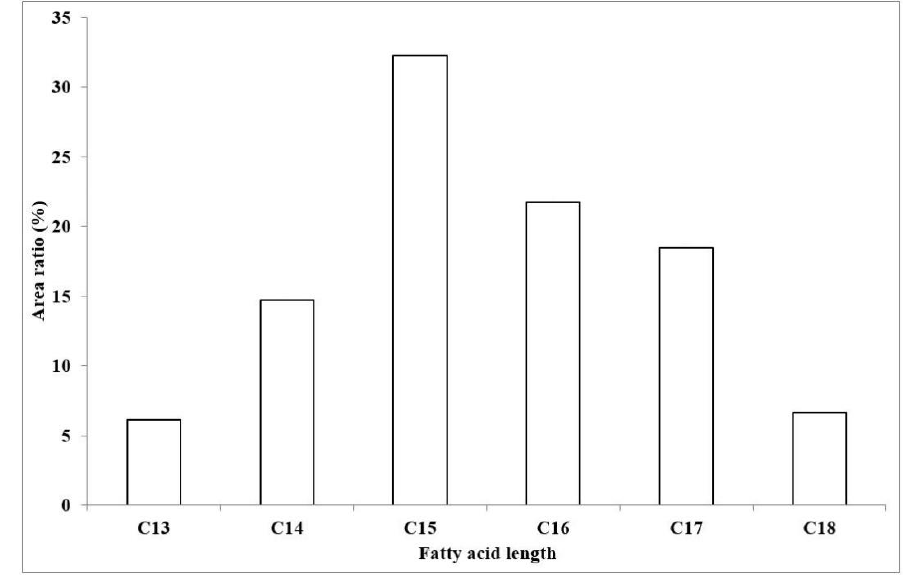
Figure 6. The ratios of the produced surfactin molecules possessing different fatty acid chain lengths based on the integrated areas of the peaks in the extracted ion chromatograms.